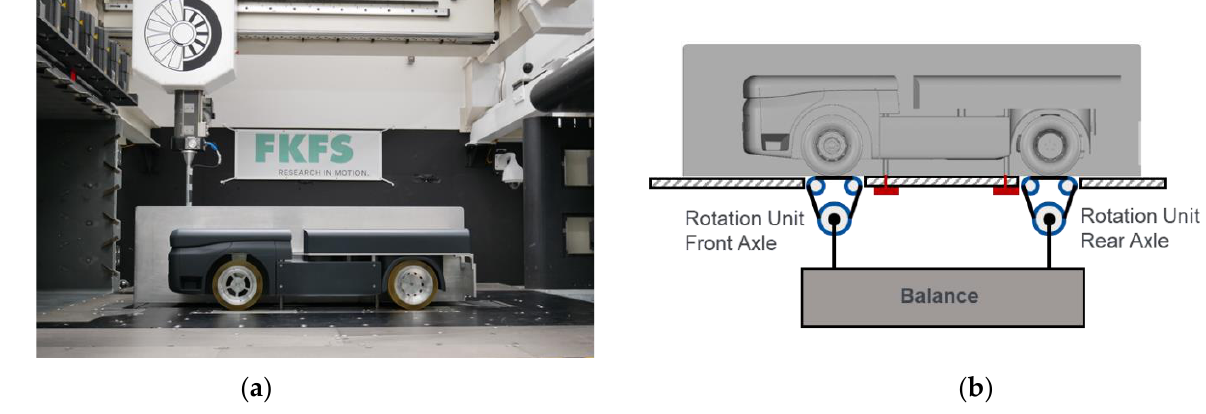
Figure 5. Wind tunnel measurements: ( a ) Vehicle model on the test section; ( b ) Sketch showing the force measurement with the balance.